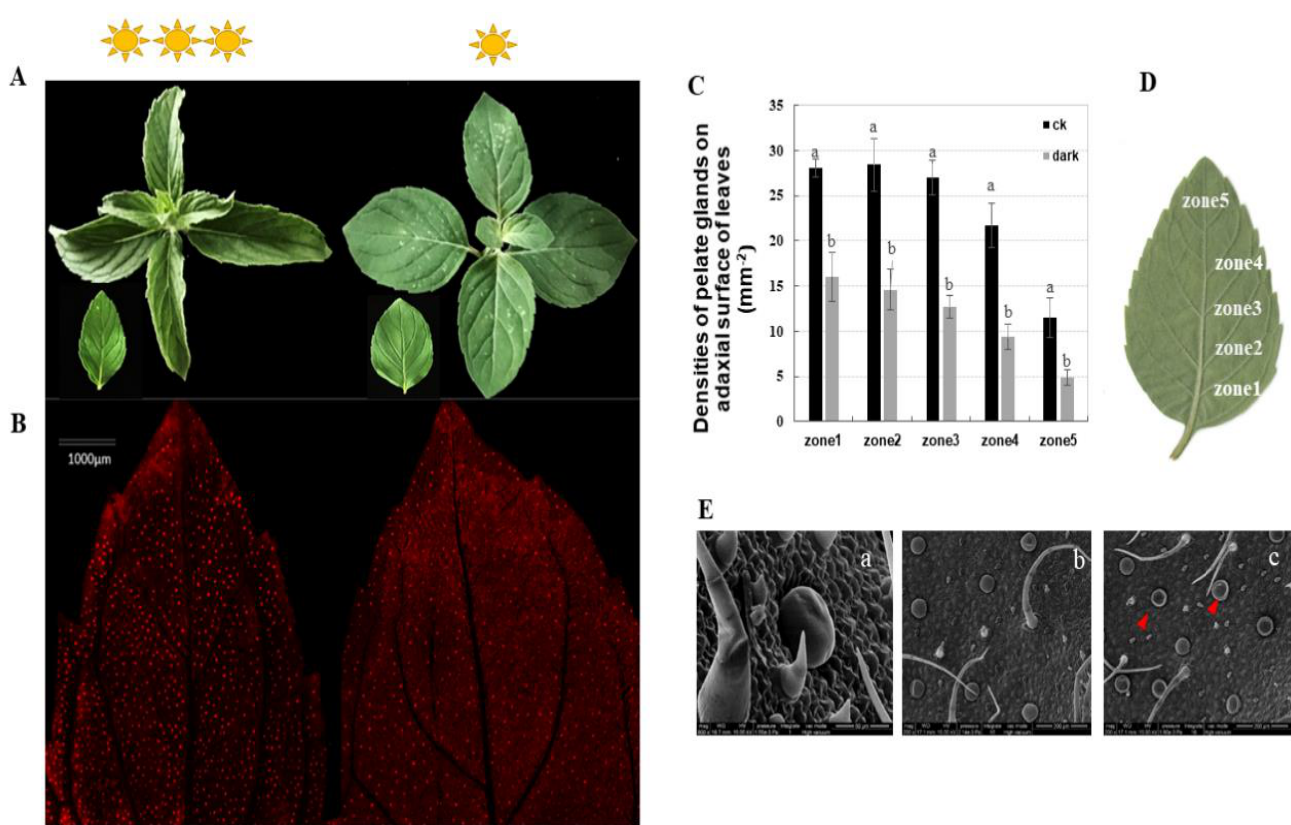
Figure 1. Phenotypes of Mentha canadensis after 4 weeks of growth under low light conditions. ( A ) The morphology of leaves at the same developmental stage under normal light conditions (left) and low light conditions (right). ( B ) The abaxial surface of leaves under fluorescence light. Red spots show the spontaneous fluorescence of peltate glandular trichomes. ( C , D ) Peltate glandular trichome densities of the abaxial surface—five leaf zones from basal to top regions of young leaves. Bars indicate the densities of peltate glandular trichomes. Error bars represent SD. ( E ) SEM micrographs showing PGTs on the abaxial leaf surface. ( a ) Morphology of peltate glandular trichomes and non-glandular trichomes; ( b ) abaxial leaf surface under normal light condition; ( c ) abaxial leaf surface under low light growth conditions; the red triangles indicate wrinkled PGTs. The analysis of trichome densities was repeated five times.